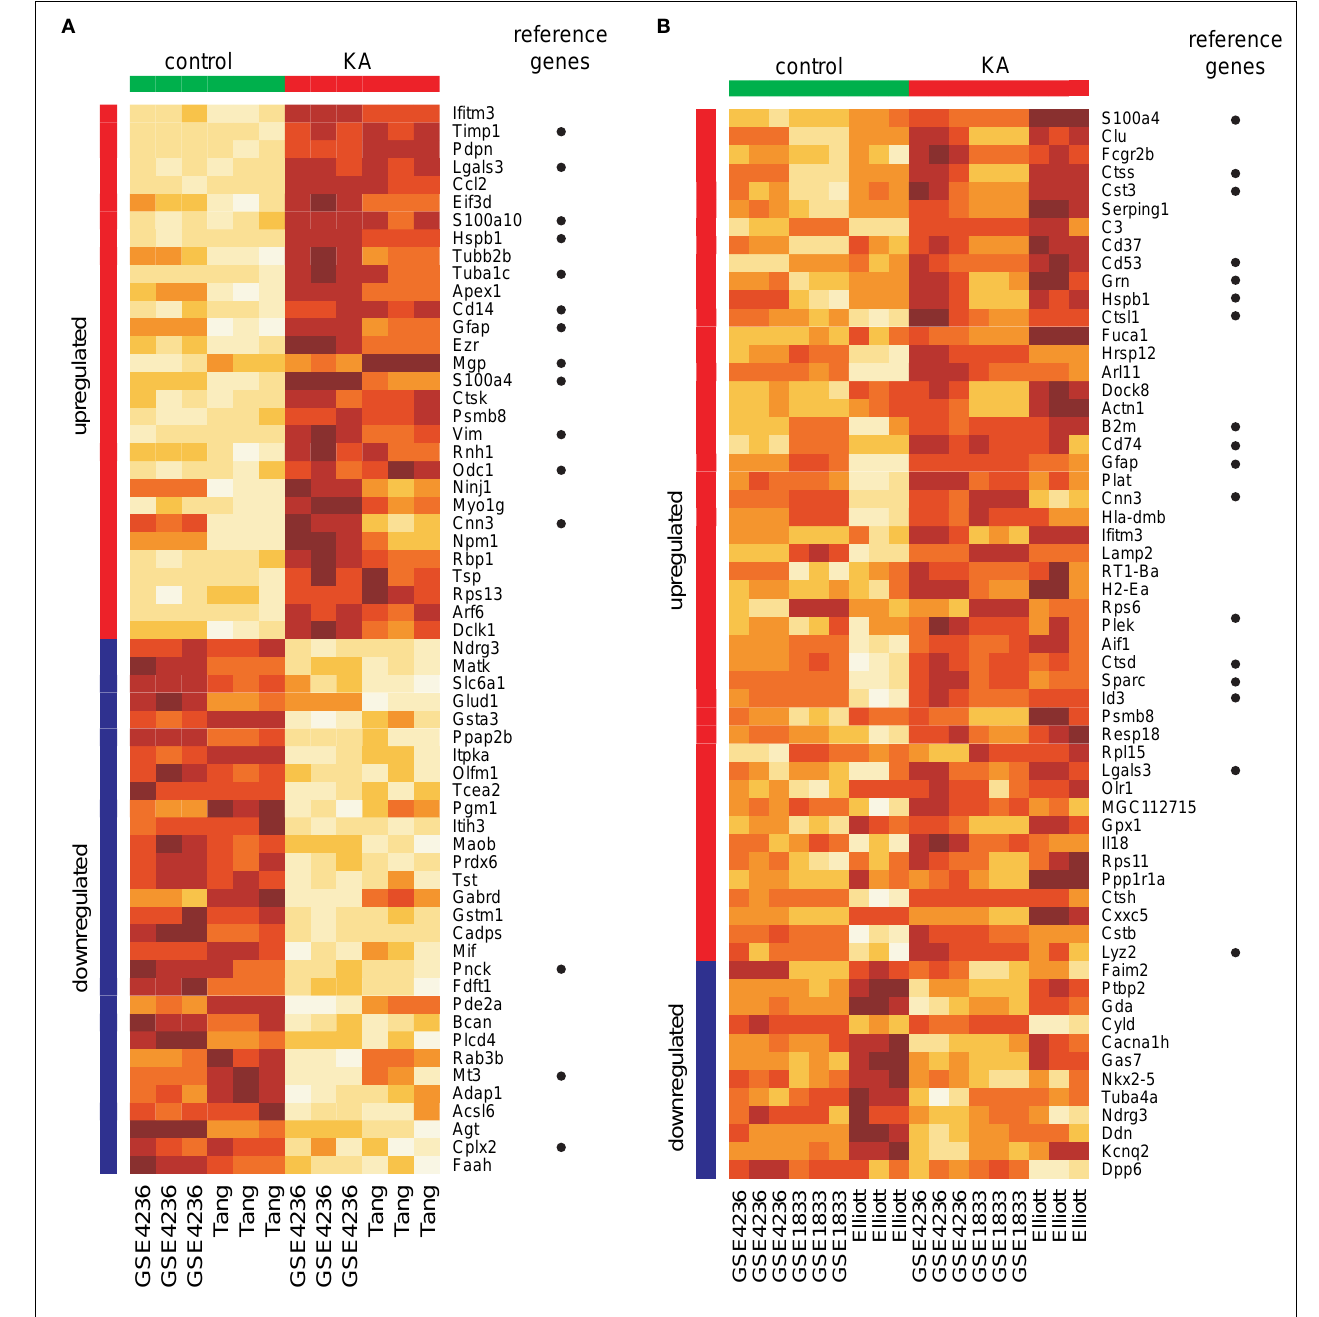
FIGURE 2 | Visualization of expression values for some of the signifi cant genes identifi ed by FEM analysis. (A) Top 50 up-regulated genes and top 50 down-regulated genes for 24-h timepoint. (B) Signifi cant genes for the 240 + -h timepoint. In each heatmap the up-regulated and down-regulated genes are ranked separately by their q -values. The direction of change is indicated by the colour bars on the left of the heatmaps (red, up-regulated; blue,